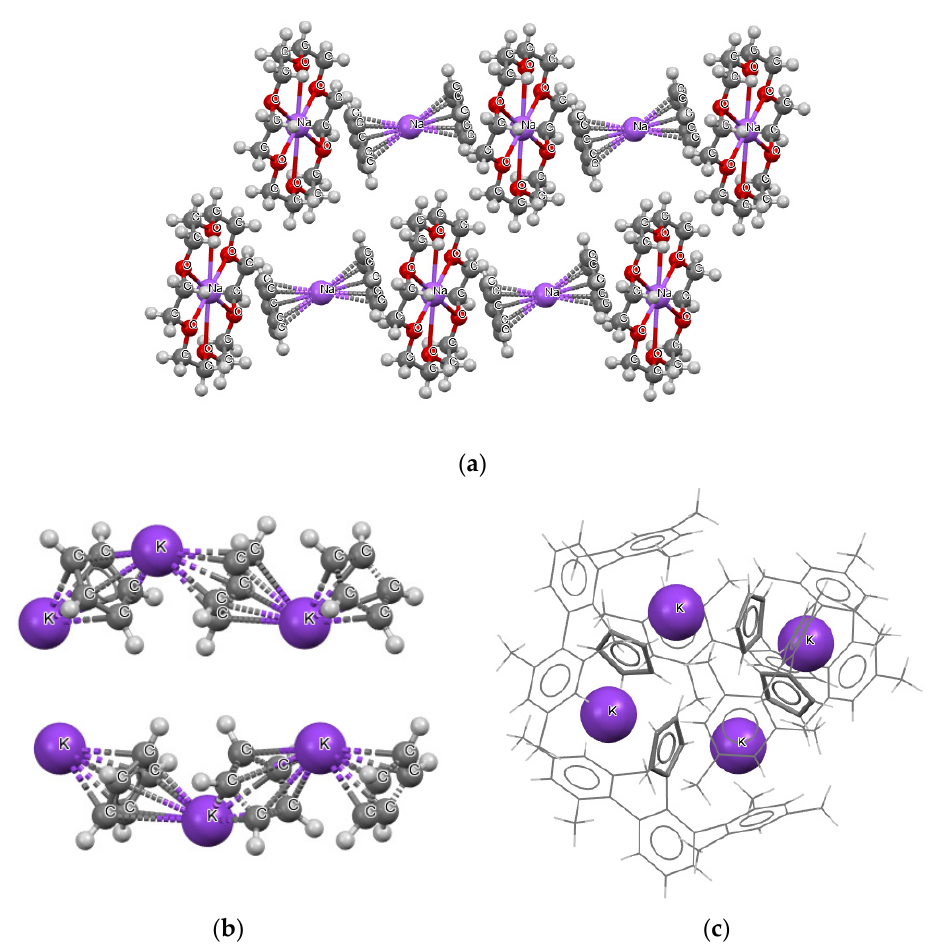
Figure 2. Three examples of crystal structures containing decker motifs: ( a ) (1,4,7,10,13,16-hexaoxacyclooctadecane)-sodium bis( η 5 -cyclopentadienyl)-sodium, ( b ) catena-(( µ 2 - η 5 , η 5 -cyclopentadienyl)-potassium), ( c ) potassium 2-(1 2 ,1 4 ,1 6 ,3 2 ,3 4 ,3 6 -hexamethyl [1 1 ,2 1 :2 3 ,3 1 -terphenyl]-2 2 -yl)cyclopentadienyl (for the simplicity of this picture, the structure is presented by sticks, except potassium cations).